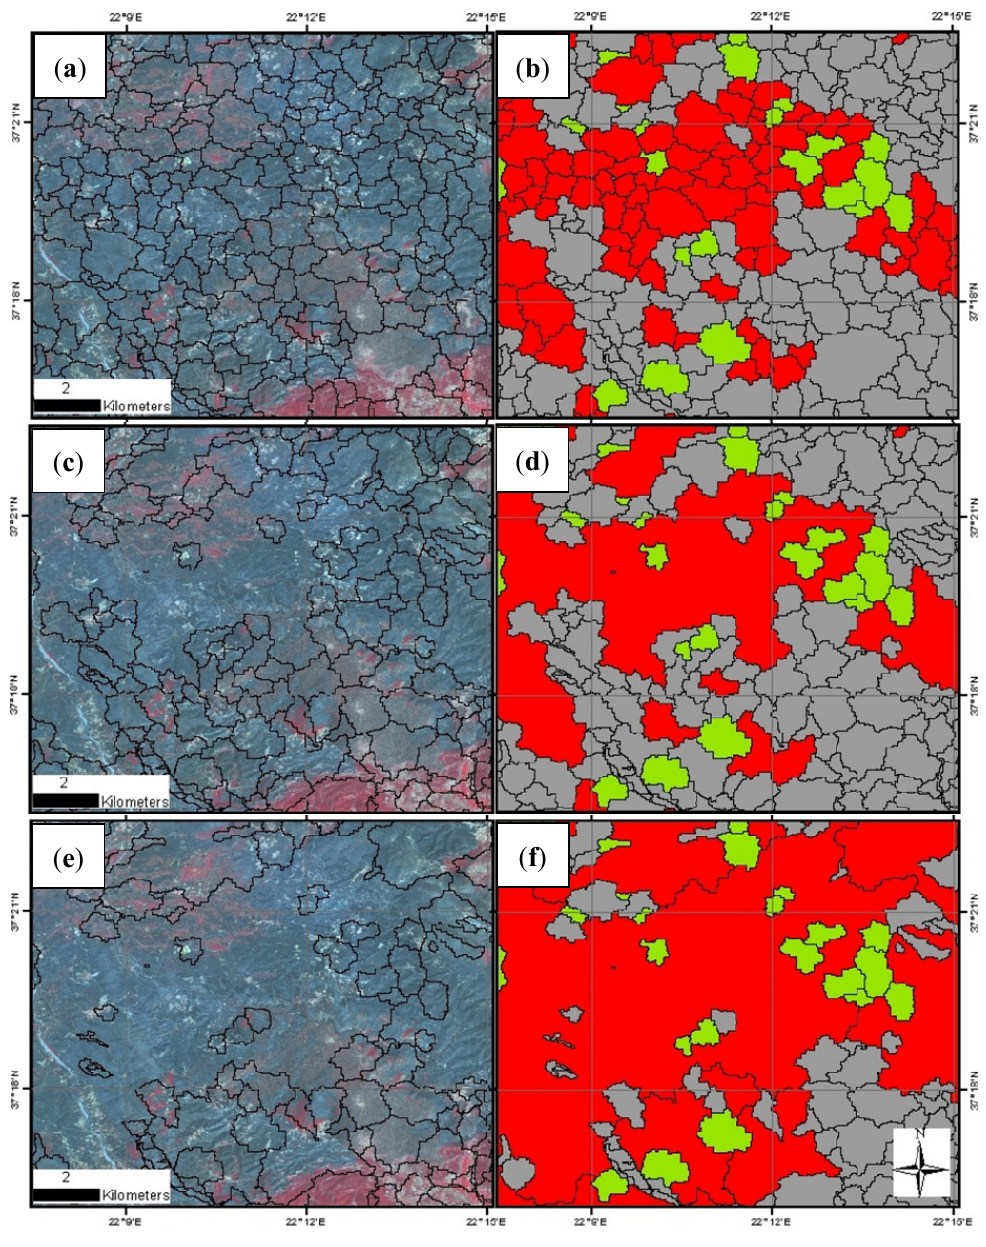
Figure 2. Segmentation of the Advanced Land Observing Satellite (ALOS) Phased Array type L-band Synthetic Aperture Radar (PALSAR) images. ( a ) Objects (in black perimeter) overlaid on the Satellites Pour l’Observation de la Terre (SPOT) image acquired after the fire event (R: Near-infrared (0.78–0.89 µm), G: Red (0.61–0.68 µm), B: Green (0.50–0.59 µm)) generated during the initial segmentation and ( b ) the objects’ classification. ( c ) Objects (in black perimeter) generated during the second segmentation overlaid on the SPOT image and ( d ) the objects’ classification. ( e ) Final objects (in black perimeter) generated after the implementation of the region-growing algorithm overlaid on the SPOT image and ( f ) the objects’